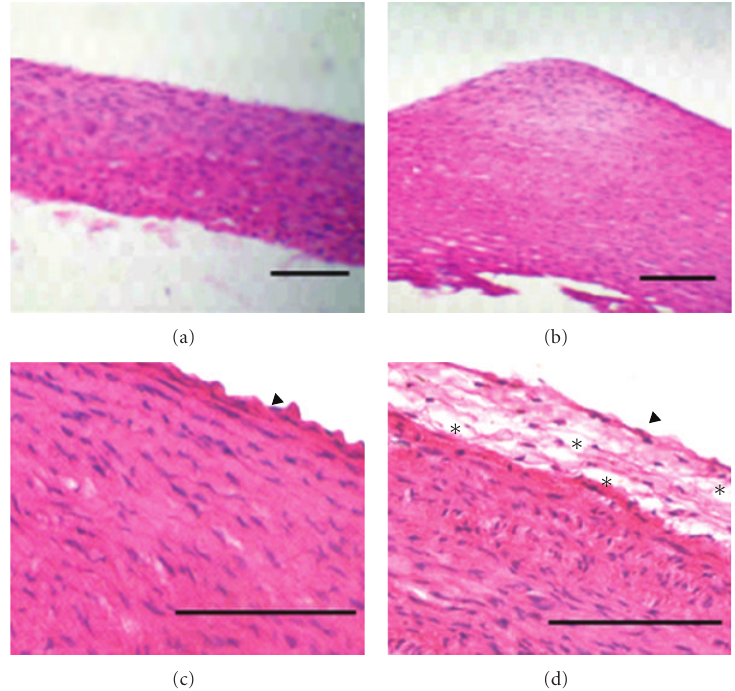
Figure 1: Histopathological analysis of rabbit’s aortic tree. Eosin/hematoxylin staining reveals a normal morphology of aortas in control animals (a) and (c), while aortas of Lipofundin group show an intimal thickening, characterized by a vascular tissue architecture distortion and large extracellular spaces, probably filled with lipids (asterisks) (b) and (d). Arrow head: endothelial cells. Magnification 10 × (a) and (b) and 40 × (c) and (d). Scale bar, 20 μ